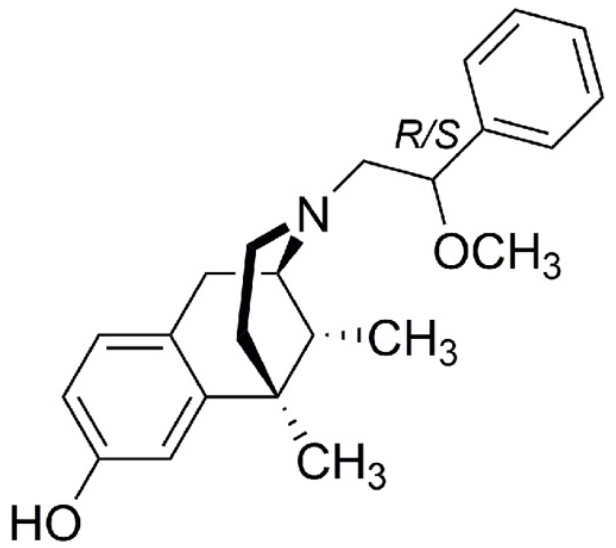
Figure 1. Structure of benzomorphan-based ligand LP2.